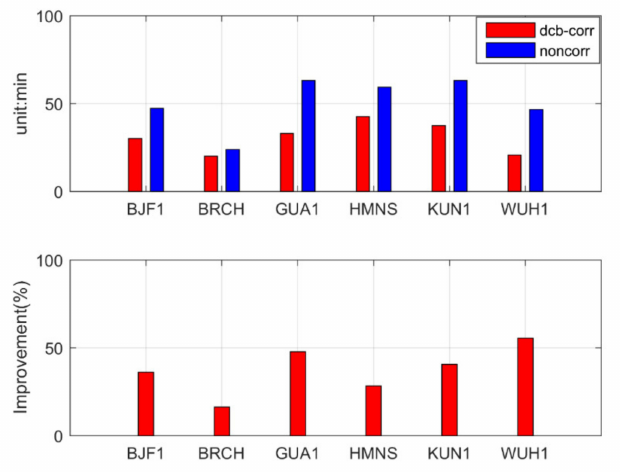
Figure 23. Average convergence time and the improvement of B1C/B2a PPP with different schemes for six stations.